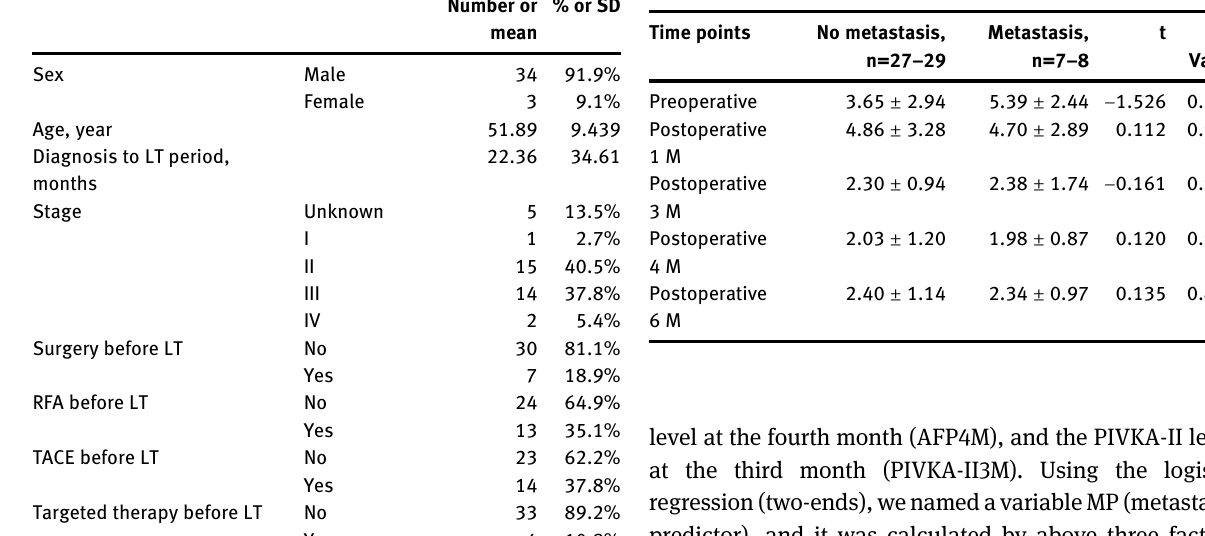
at the third month (PIVKA-II3M). Using the logistic regression (two-ends), we named a variable MP (metastasis predictor), and it was calculated by above three factors using the logistic regression. As the ROC curve shown (Figure 1), the AUC of MP was 0.858, with a cutoff value of 0.328 (sensitivity=0.75, speci fi city=0.97).